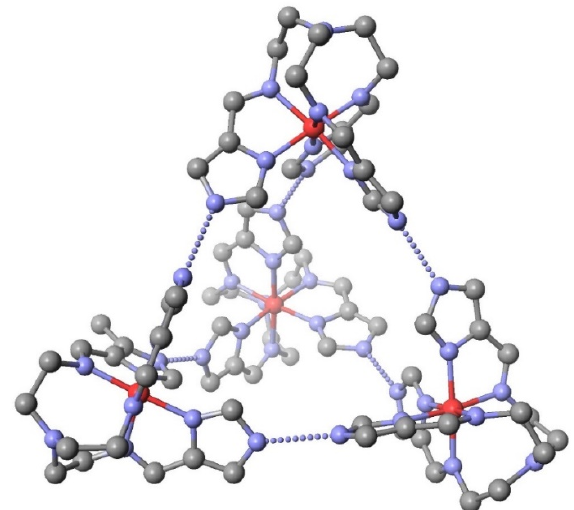
Figure 13. The supramolecular structure of [Fetren(5Me-4ImH 0.5 ) 3 ](ClO 4 ) 1.5 . All hydrogen atoms and methyl groups have been removed for clarity. There are six N imidazole –H ... . N imidaxolate hydrogen bonds shown as a dashed line. Fach complex forms three hydrogen bonds to each of the other three complexes. The iron atoms are on the vertices of a perfect tetrahedron.